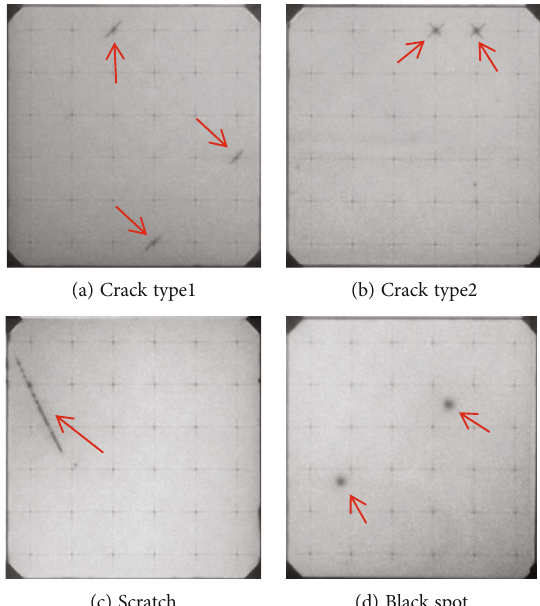
Figure 9: Types of cell defects detected in this paper.